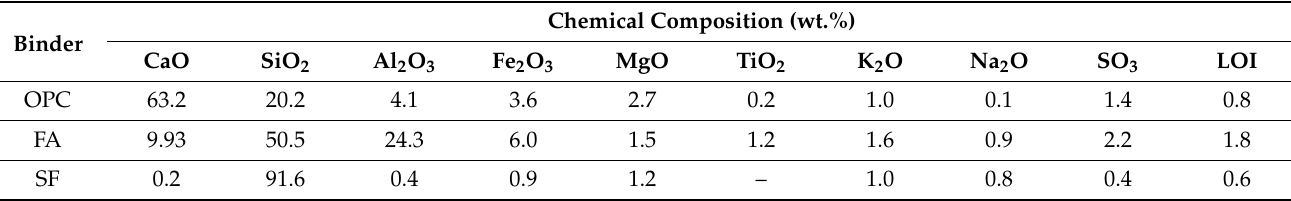
Table 1. Chemical composition of binders.